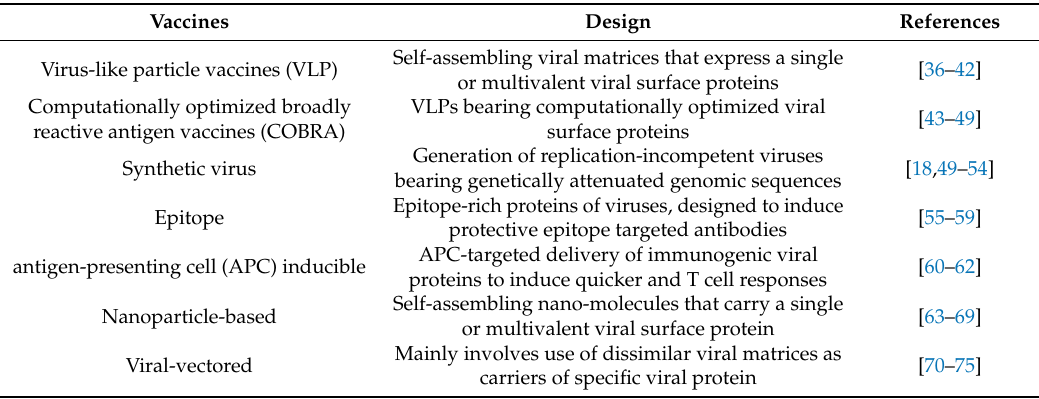
Table 1. Summary of novel influenza virus vaccine